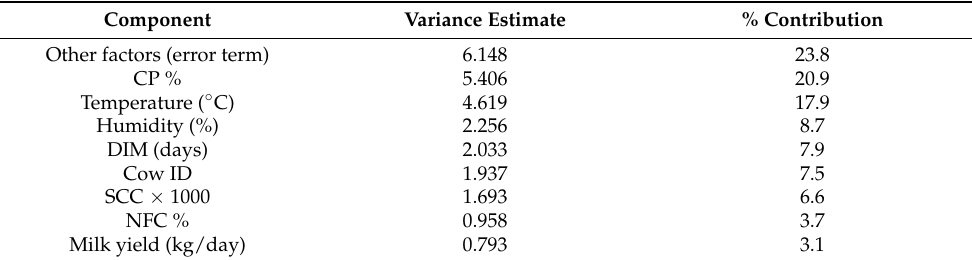
Table 3. Variance components analysis (from a generalized linear regression model) to assess the contribution of each variable to the variability of milk urea nitrogen (MUN) concentration. Data were collected from 161 Holstein cows from the Experimental Farm, University of Pretoria, during the period from February 2012 to November